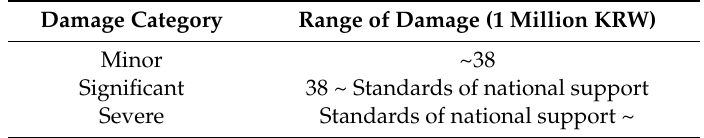
Table 1. Range of damage by damage category.